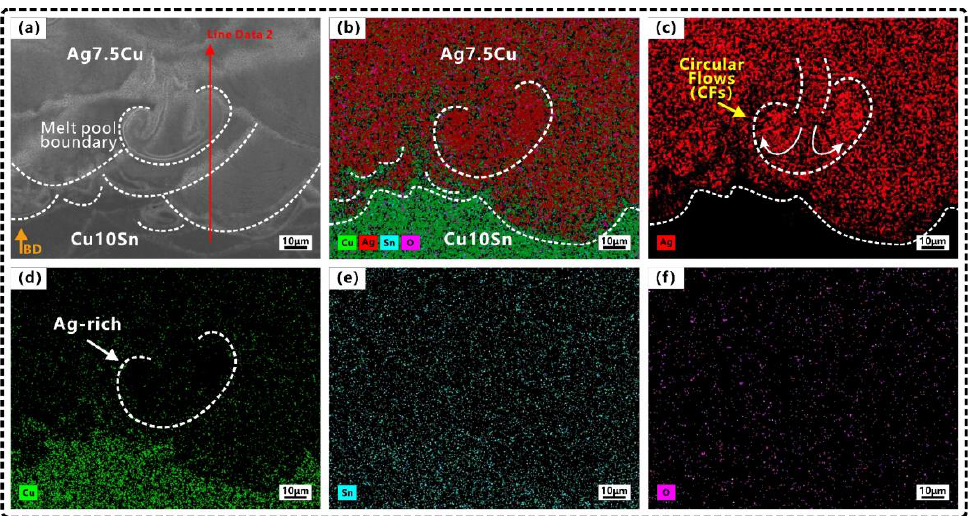
Figure 6. Elemental distributions at C/A interface: ( a ) SEM image; ( b ) EDS mapping of ( a ); ( c – f ) showing elemental distributions of Ag, Cu, Sn, O, respectively. Orange arrow indicates the building direction (BD).